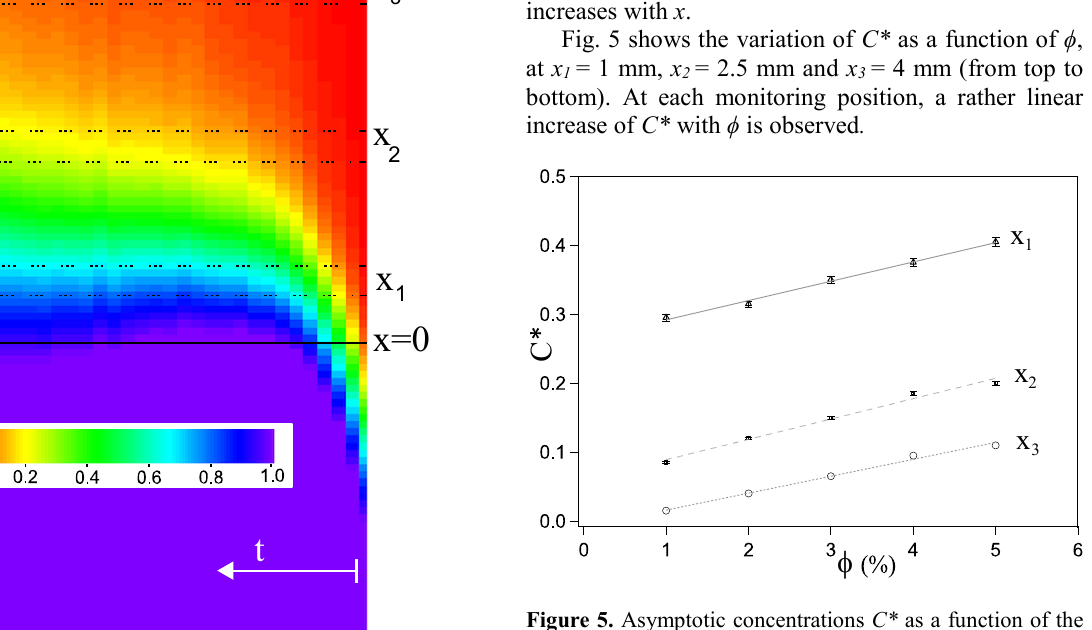
Figure 5. Asymptotic concentrations C* as a function of the solid fraction ϕ ( : x 1 = 1 mm, □ : x 2 = 2.5 mm, ○ : x 3 = 4 mm). The solid, dashed, and dotted lines are linear fits over the data △ points for x 1 , x 2 and x 3 respectively .